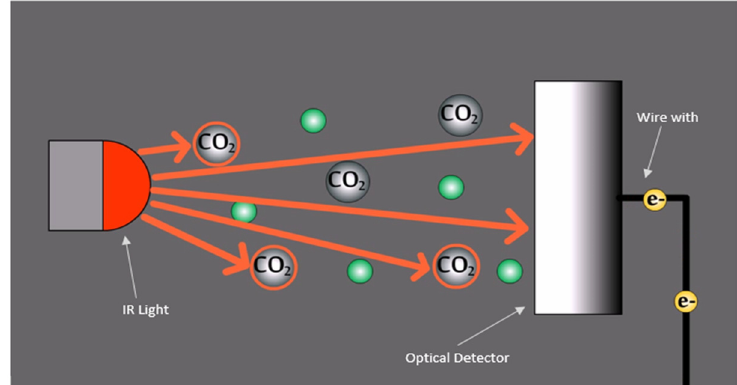
Figure 10. Setup of the non-dispersive infrared (NDIR) sensor. The infrared (IR) light with a wavelength of 700 nm to 1 µm is partially absorbed by carbon dioxide and partially transmitted through to the detector.